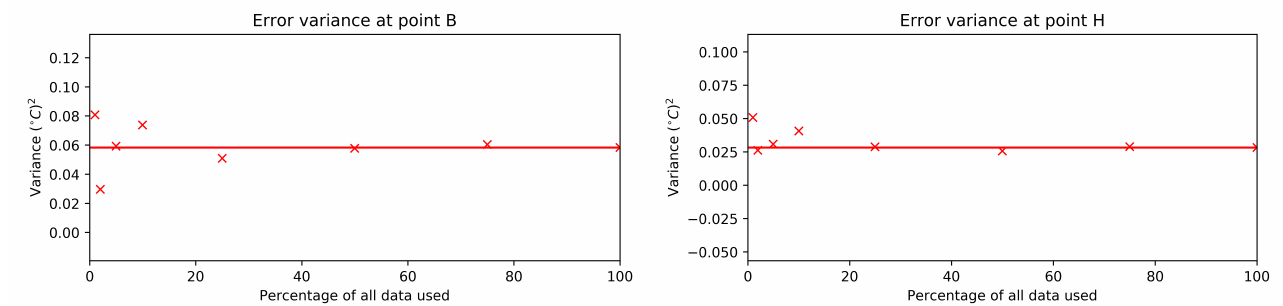
Figure 6. Sensitivity of PROM to the density of data. Each plot represents the computed error variance averaged for many realisations of randomly selected data points. The number of realisations for which PROM method failed to obtain a result are the same as in the idealised case (see Figure 4 on page